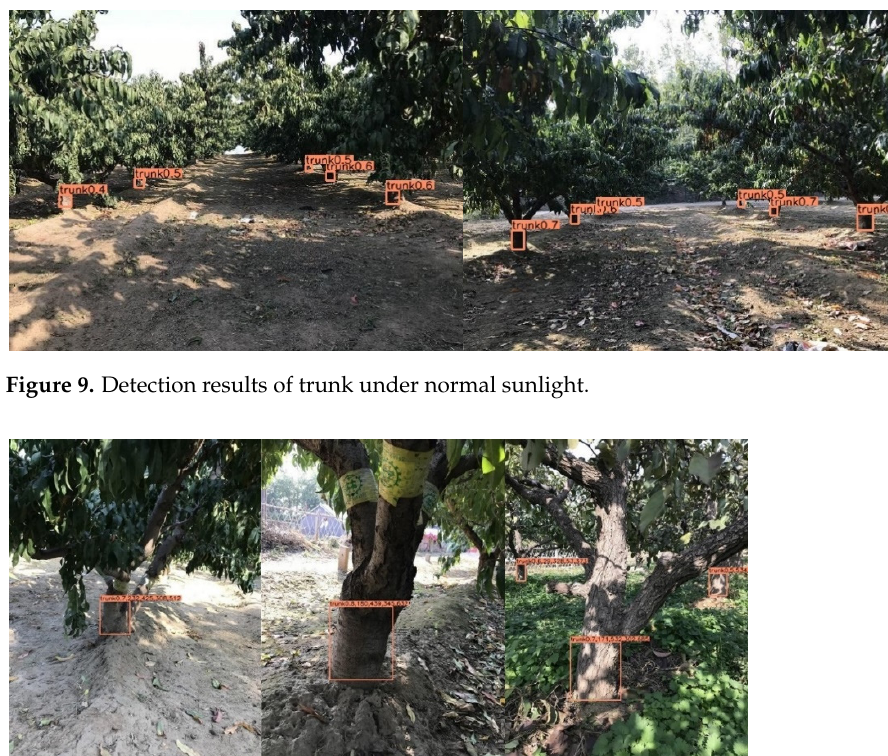
Figure 8. Detection results of tree and trunk under strong sunlight.